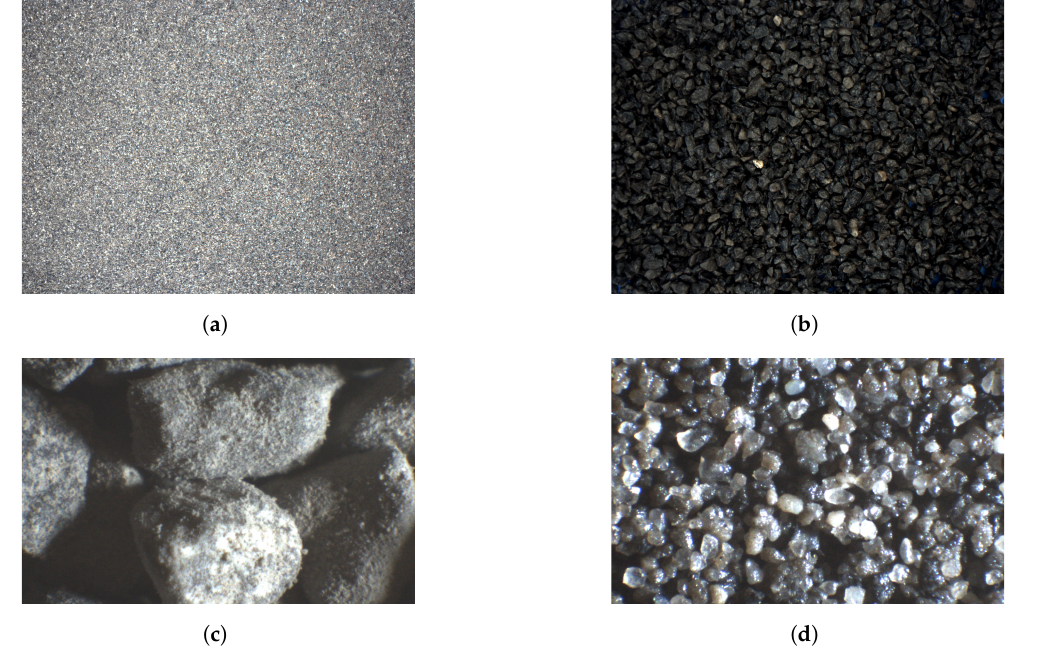
Figure 9. Samples of tested material: ( a ) normal mode, 0.5% moisture; ( b ) normal mode, 5% moisture; ( c ) macro image, 1% moisture; ( d ) macro image, 9% moisture.